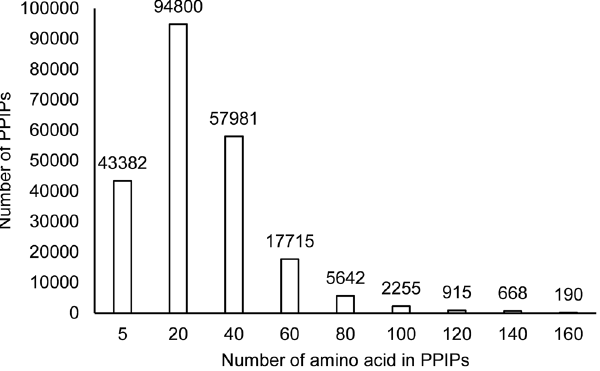
Figure 5. Involvement of amino acids in